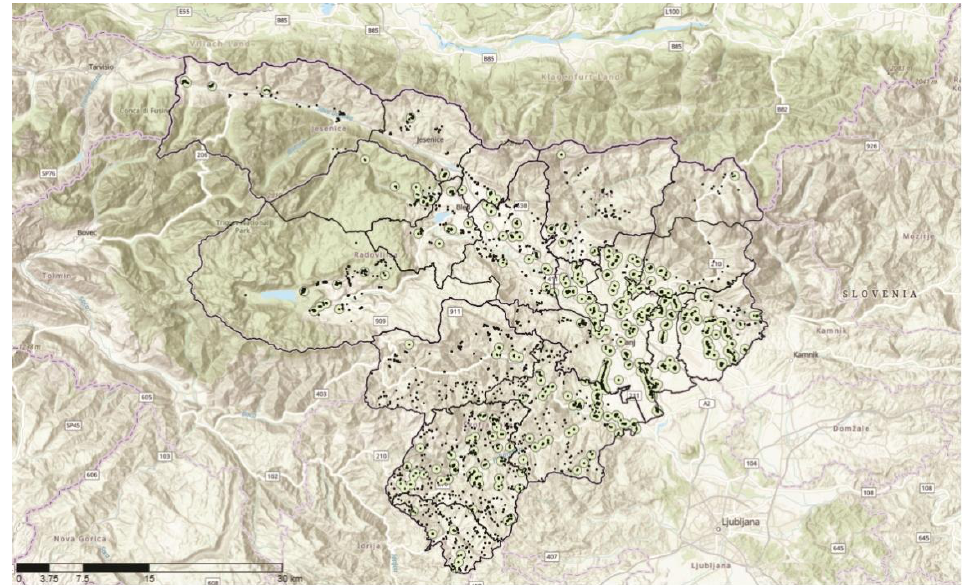
Figure 5. Potentially clusters of LU.